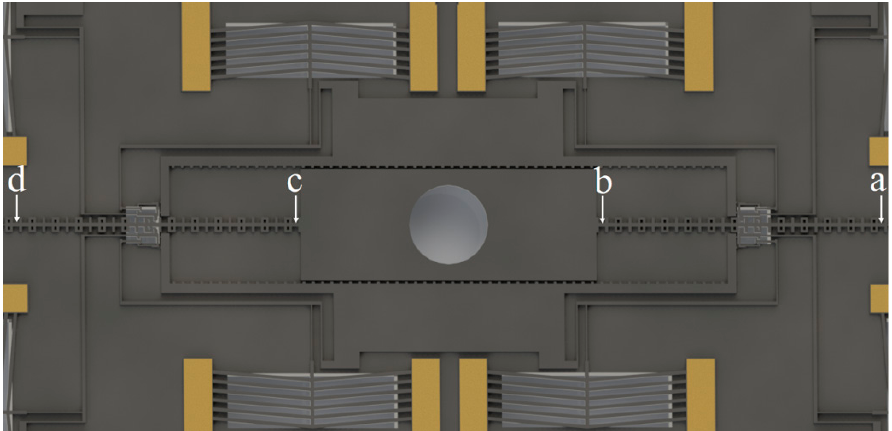
Figure 5. The illustration of teeth width sequence on the both sides of interrupter.